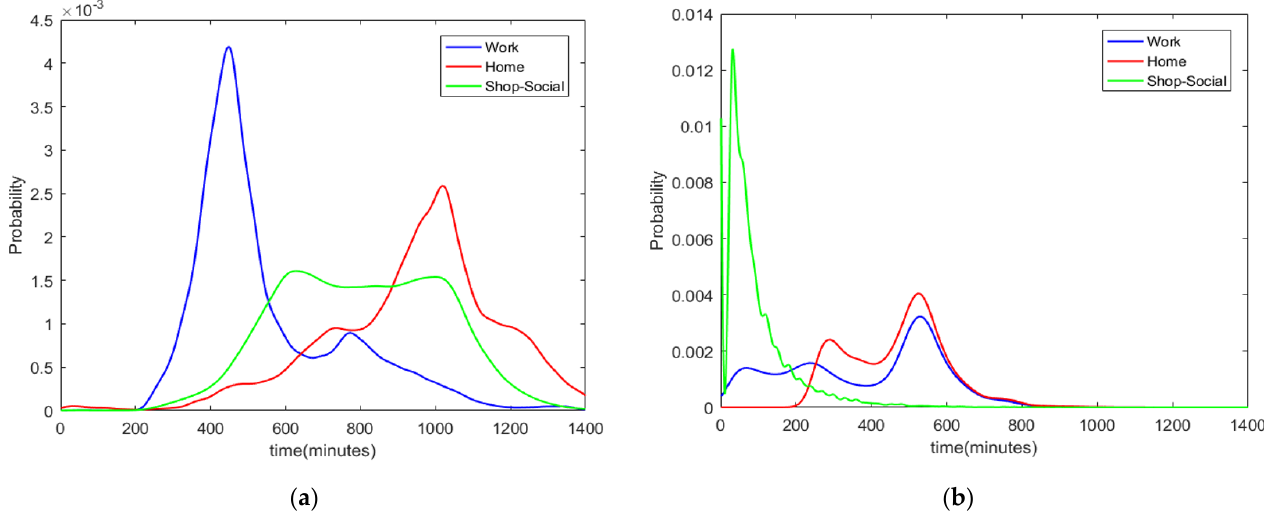
Figure 7. ( a ) PDF of electric vehicles’ connection time; ( b ) PDF of electric vehicles’ dwell time .